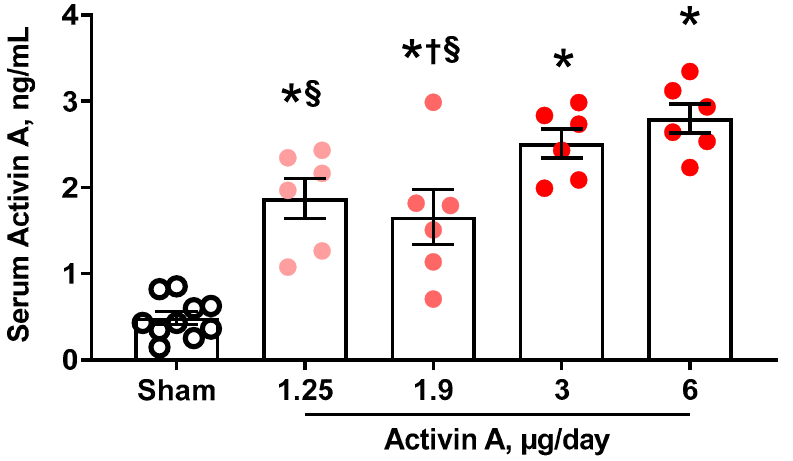
Figure 1. Circulating levels of activin A on gestational day 19 in sham (black open circles) and pregnant rats infused with 1.25 µ g/day, 1.9 µ g/day, 3 µ g/day, and 6 µ g/day of human recombinant activin A (solid red circles). Data are mean ± SEM. * p < 0.05 vs. sham, † p < 0.05 vs. 3 µ g/day, § p < 0.05 vs. 6 µ g/day.